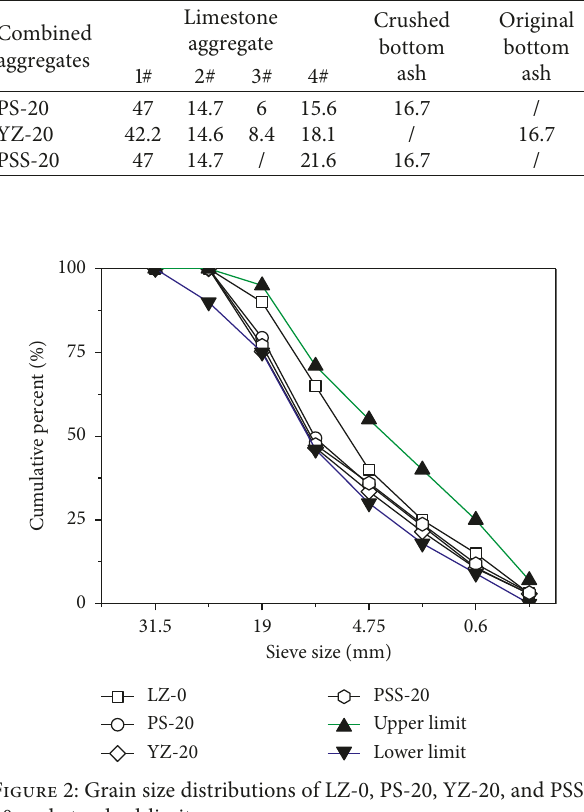
Table 3: Proportion of combined aggregates (%).